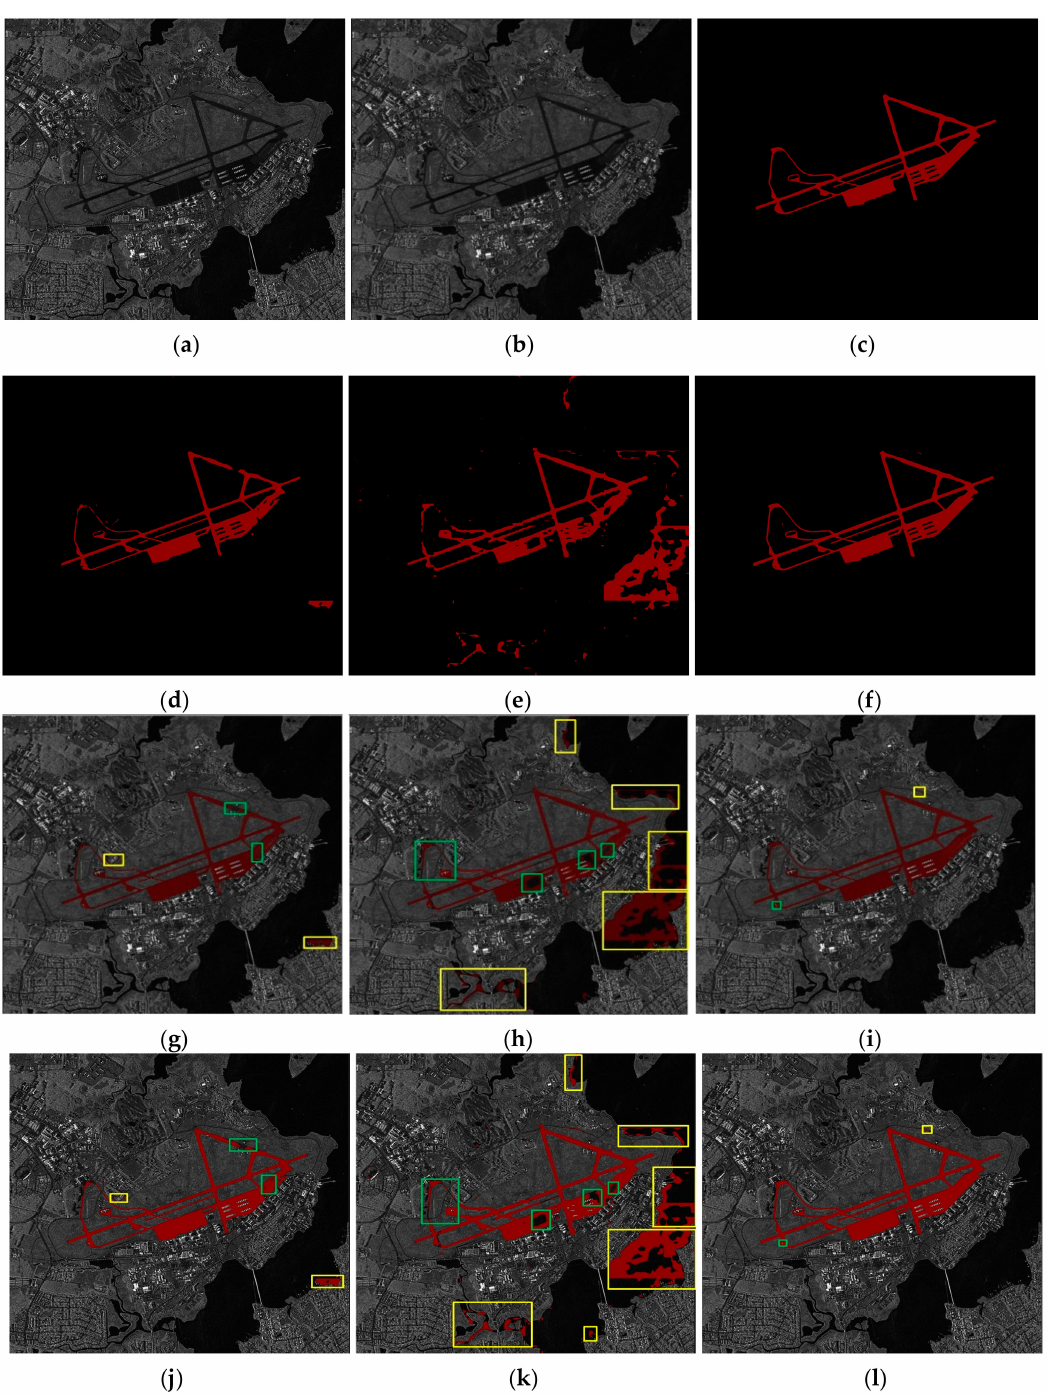
Figure 10. The experiment result for Airport II. ( a ) SAR image of Airport II from Gaofen-3. ( b ) The down-sampled SAR image of ( a ) by 5 times. ( c ) The ground truth of the airport for ( b ). ( d ) The extraction result of ( b ) by RefineNet. ( e ) The extraction result of ( b ) by DeepLabV3. ( f ) The extraction result of ( b ) by MDDA. ( g ) The fusion map of ( d , b ). ( h ) The fusion map of ( e , b ). ( i ) The fusion map of ( f , b ). ( j ) The fusion map of ( a , d ) up-sampled by 5 times. ( k ) The fusion map of ( a , e ) up-sampled by 5 times. ( l ) The fusion map of ( a , f ) up-sampled by 5